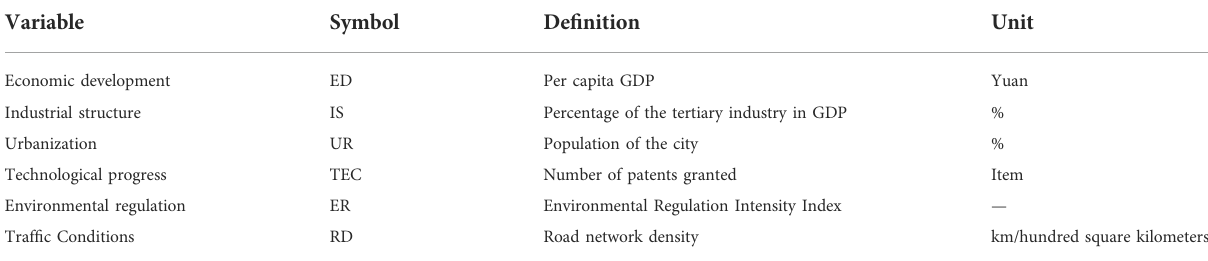
TABLE 3 Variable descriptions of the in fl uencing